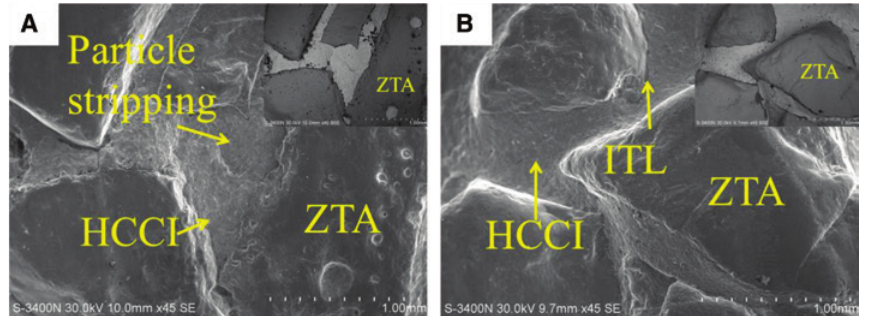
; (B) samples of S . N Y